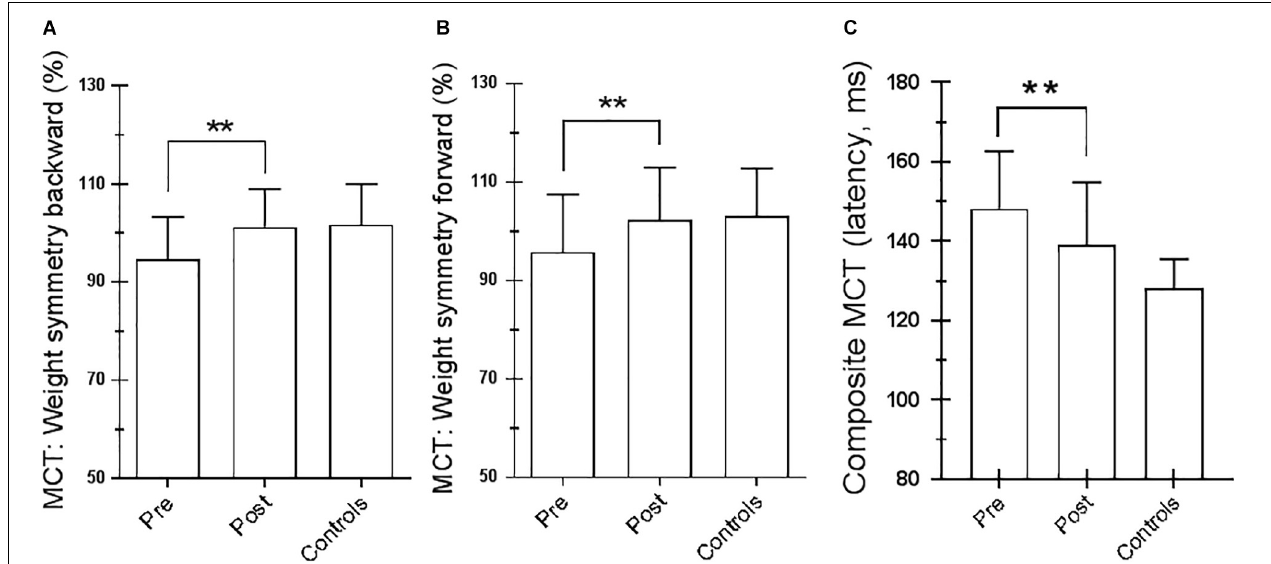
FIGURE 4 | Motor control test (MCT). (A) Weight symmetry (WS) in backward pretraining and posttraining; ∗∗ p = 0.007 (paired t -test). (B) WS in forward pretraining and posttraining; ∗∗ p = 0.03 (paired t -test). (C) Averaged latencies of the right and left feet. ∗∗ p = 0.001 (paired t -test). Statistical analysis is performed between pretraining and posttraining. Values are reported as mean and standard deviation. The third column of each figure represents the control values. Statistical analysis is performed between pretraining and posttraining only in Parkinson’s disease (PD) subjects.